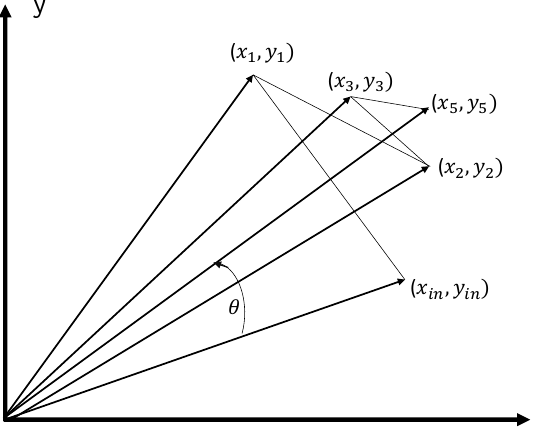
Figure 1. Rotation of a vector using microrotations.